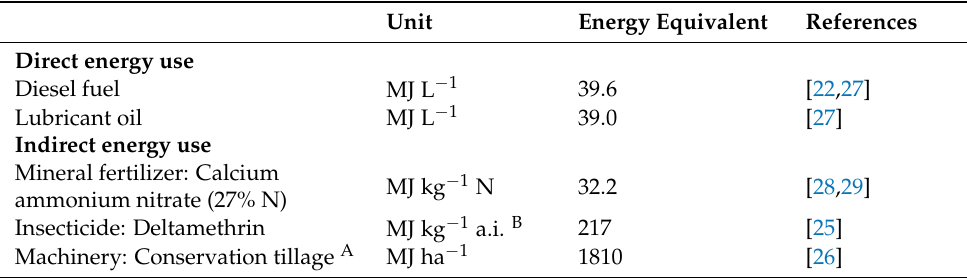
Table 3. Energy equivalents for production facilities.